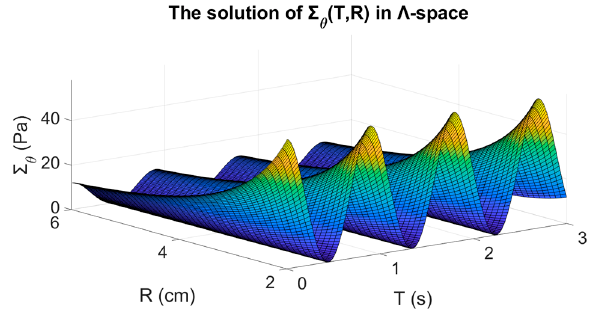
Figure 2. The ventricular cylinder's radial stress Σ -(T,R).